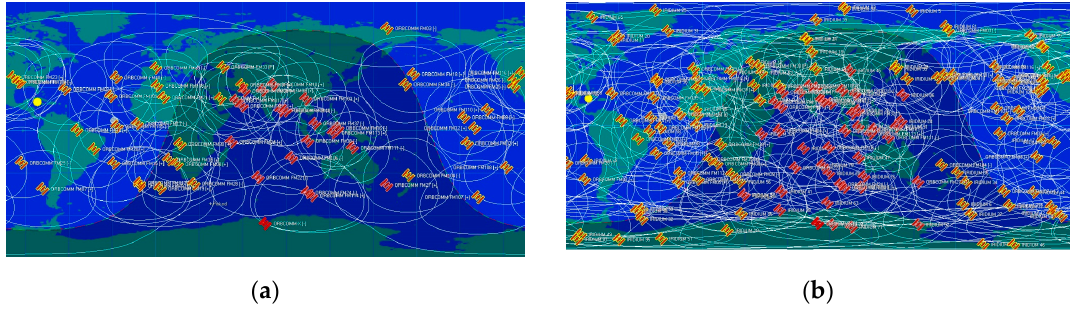
Figure 1. ( a ) Coverage of the Orbcomm constellation in global world map; ( b ) coverage of the Orbcomm and Iridium-Next constellations on a global world map.